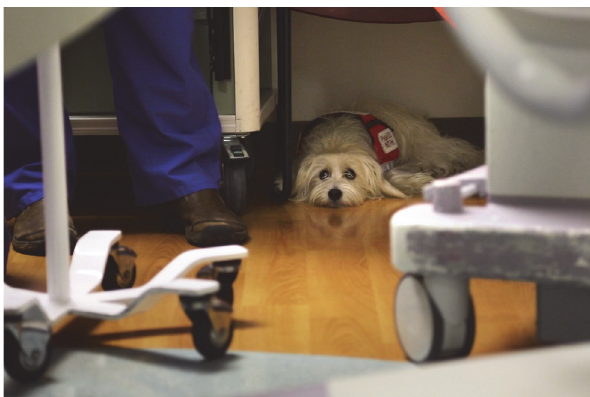
Figure1:Servicedogpresentintheproceduresuite.Shewaspresent under the handler’s chair near the anesthesia team and would alert to any perceived detection of mast cell